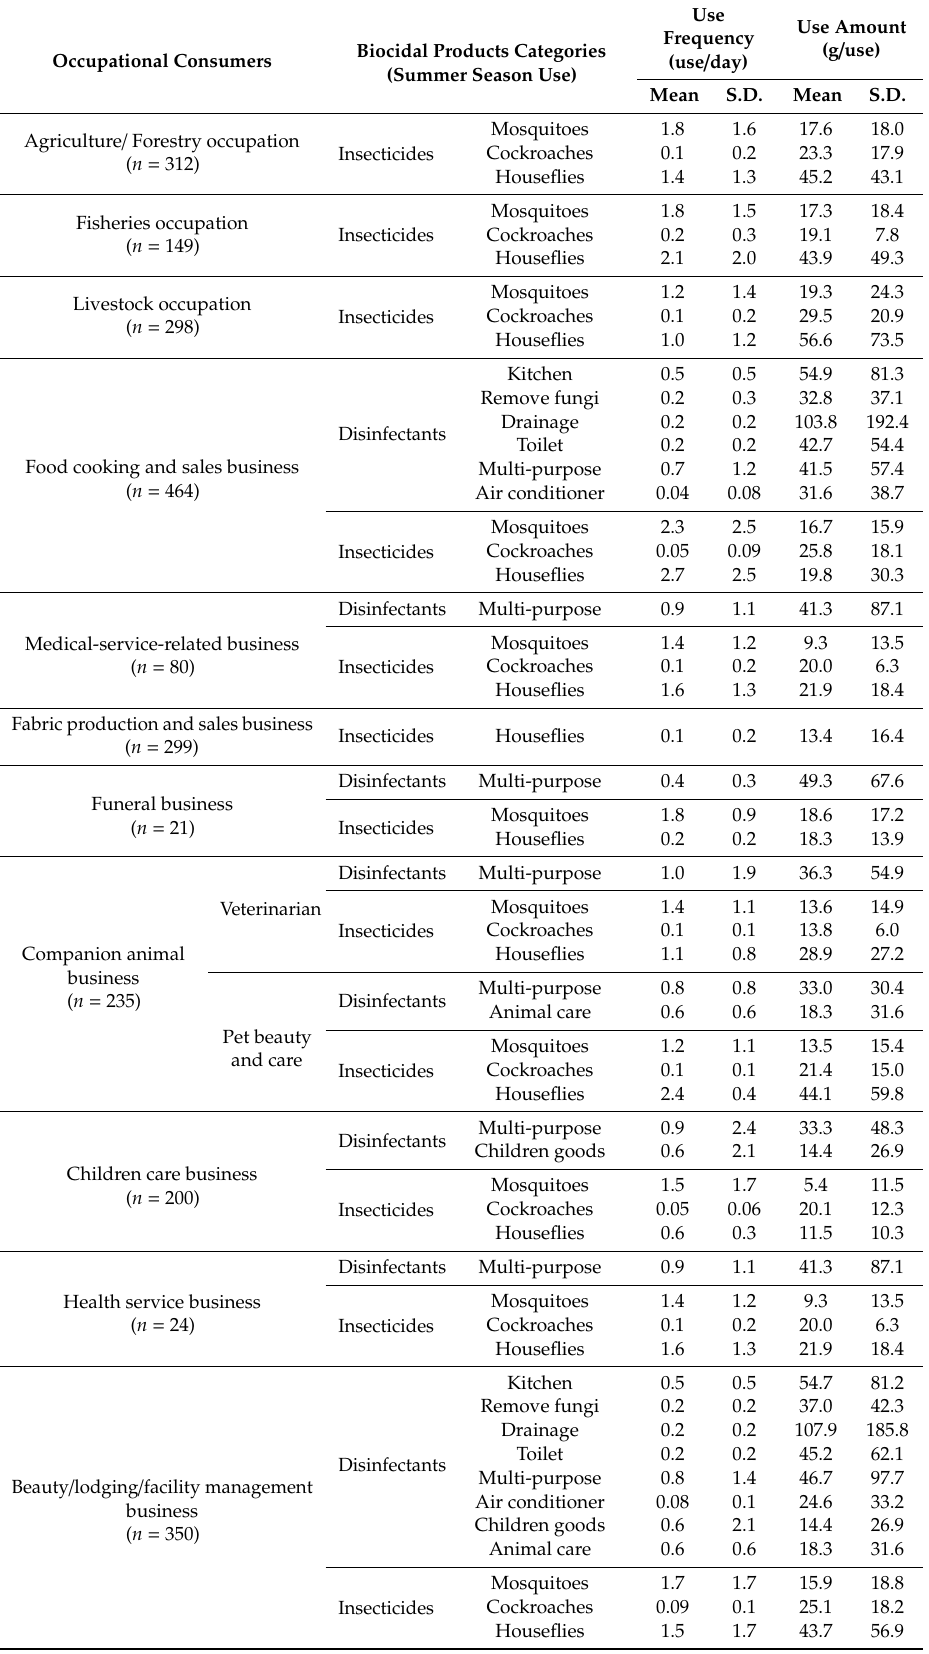
Table 3. Exposure factor values of biocidal products adjusted for occupational